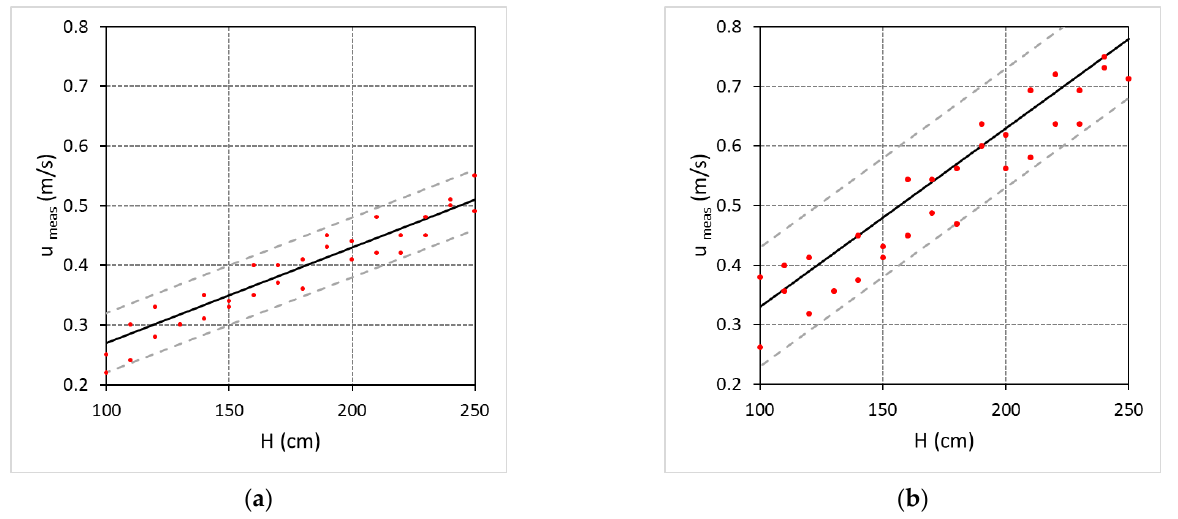
Figure 11. Velocity peaks versus tidal heights: ( a ) flood tide and ( b ) ebb tide. Dashed lines display 95% interval of confi- dence [31].